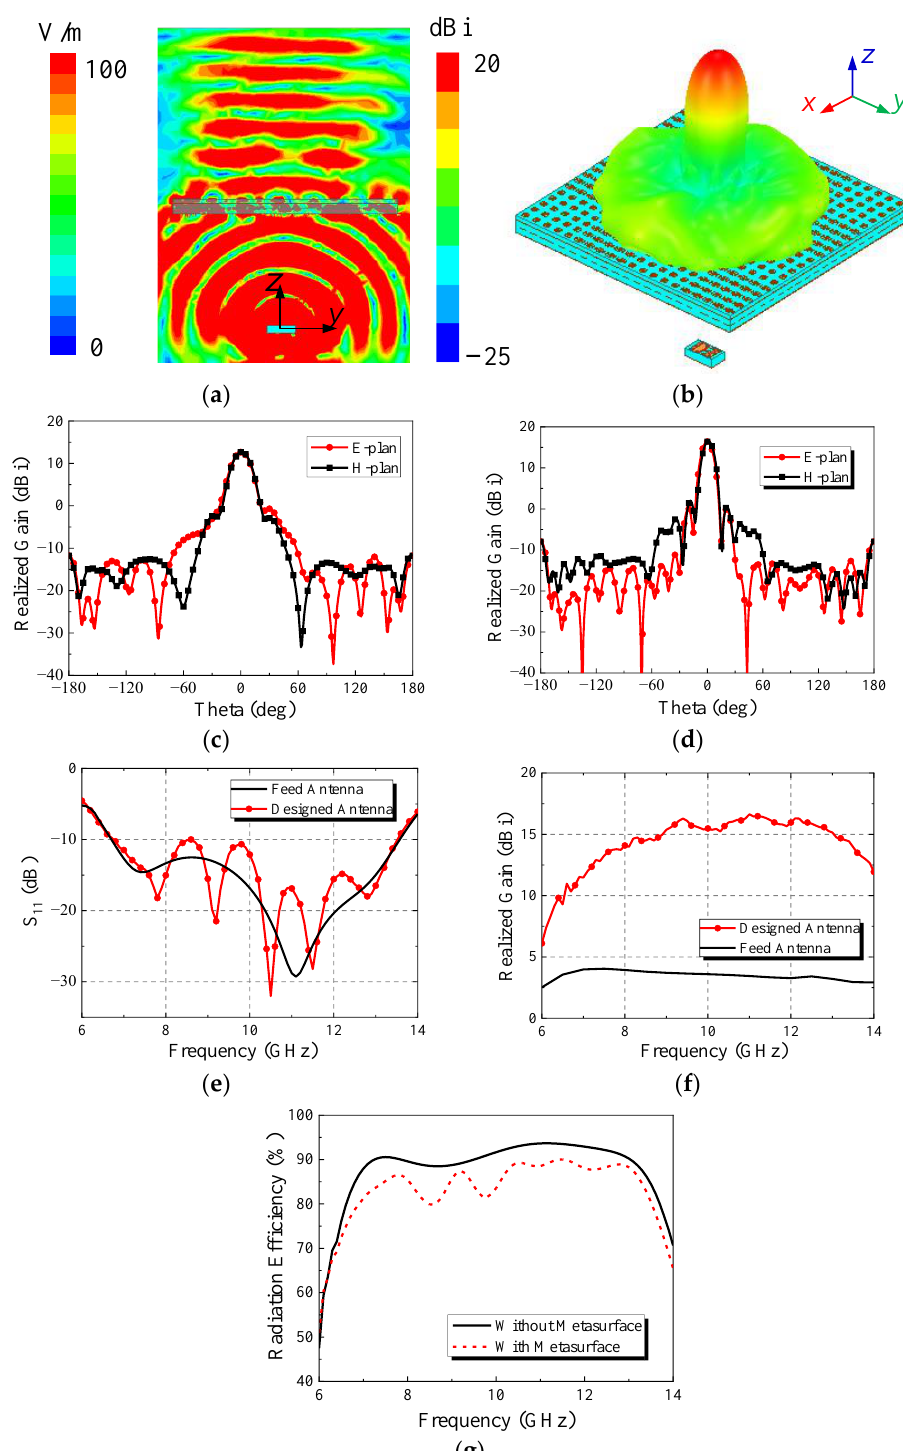
Figure 14. Simulation results of antenna: ( a ) electric field distribution of yoz plane at 10 GHz; ( b ) three-dimensional far-field pattern at 10 GHz; ( c ) radiation pattern at 7.4 GHz; ( d ) radiation pattern at 11.1 GHz; ( e ) S 11 curve; ( f ) maximum radiation direction gain; ( g ) radiation efficiency. Figure 15 is the surface current distribution of the antenna at each resonant point. It can be seen from the figure that although the antenna has five resonant points, the current distri- bution at the four resonant points (9.2 GHz, 10.5 GHz, 11.5 GHz and 12.8 GHz) is similar and belongs to the same resonant mode. By comparing it with Figure 13b, it can be seen that the